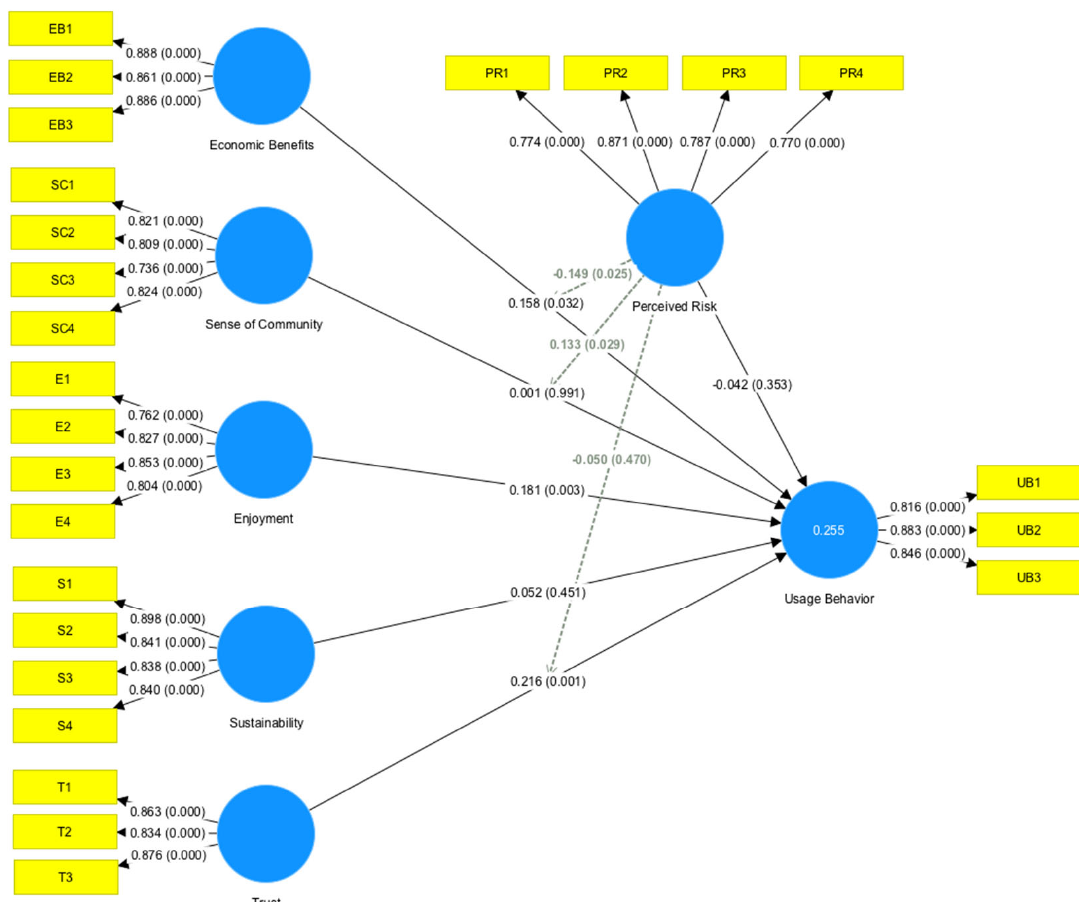
Figure 4. The moderating effect of perceived risk on the relationship between trust and usage be ‐ havior.